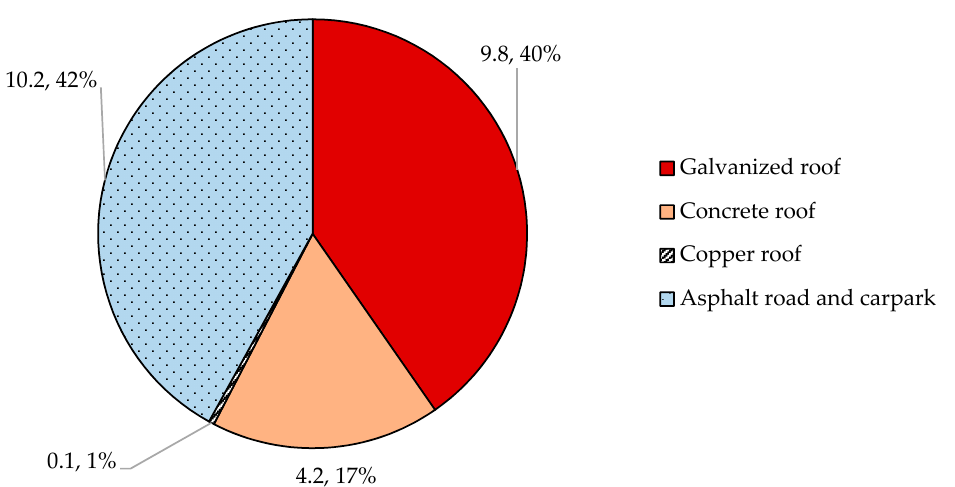
Figure 2. Map of impermeable surfaces and stormwater sampling sites in the Okeover Catchment, Christchurch, New Zealand.